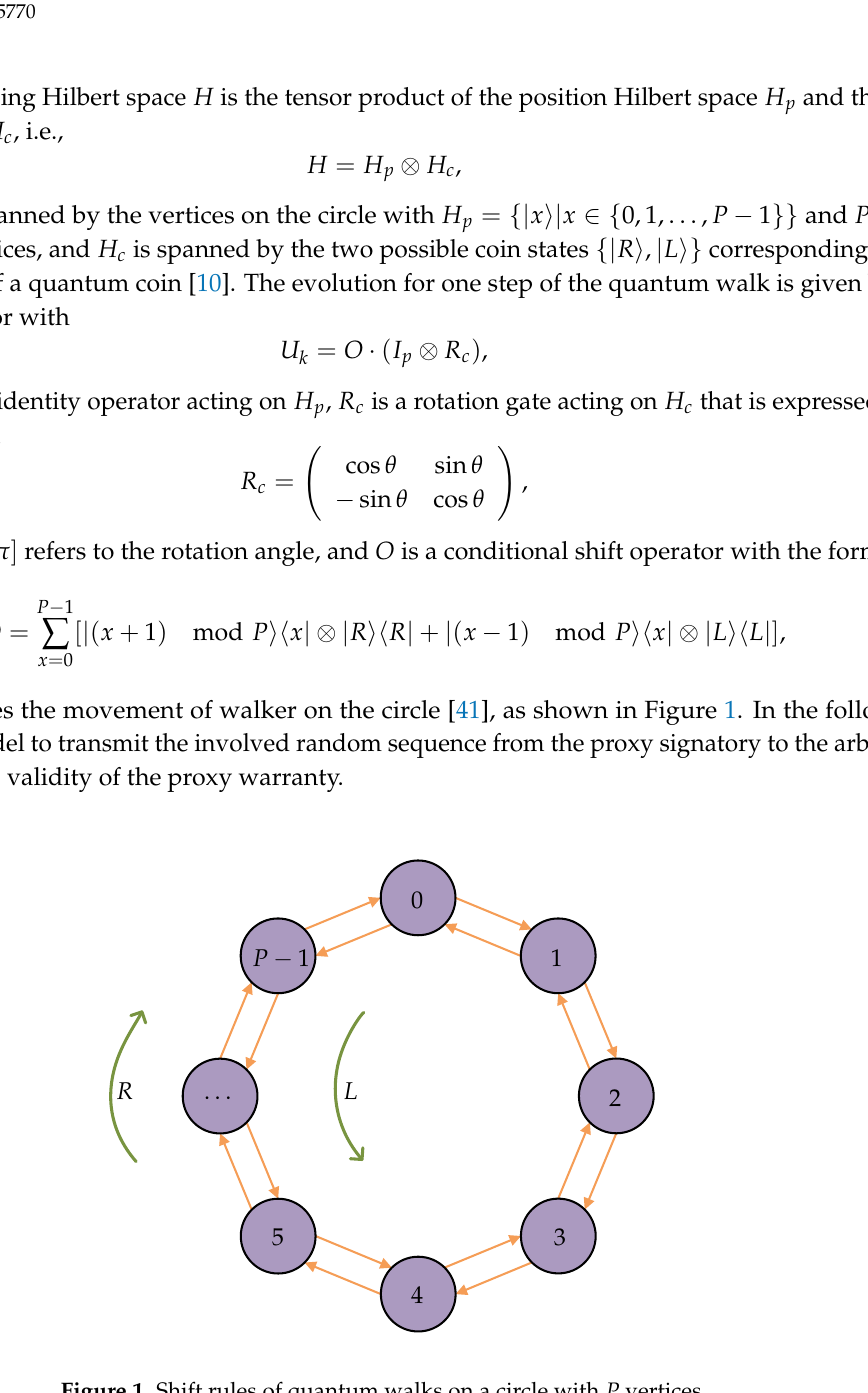
Figure 7. Schematic of the designed quantum proxy signature scheme